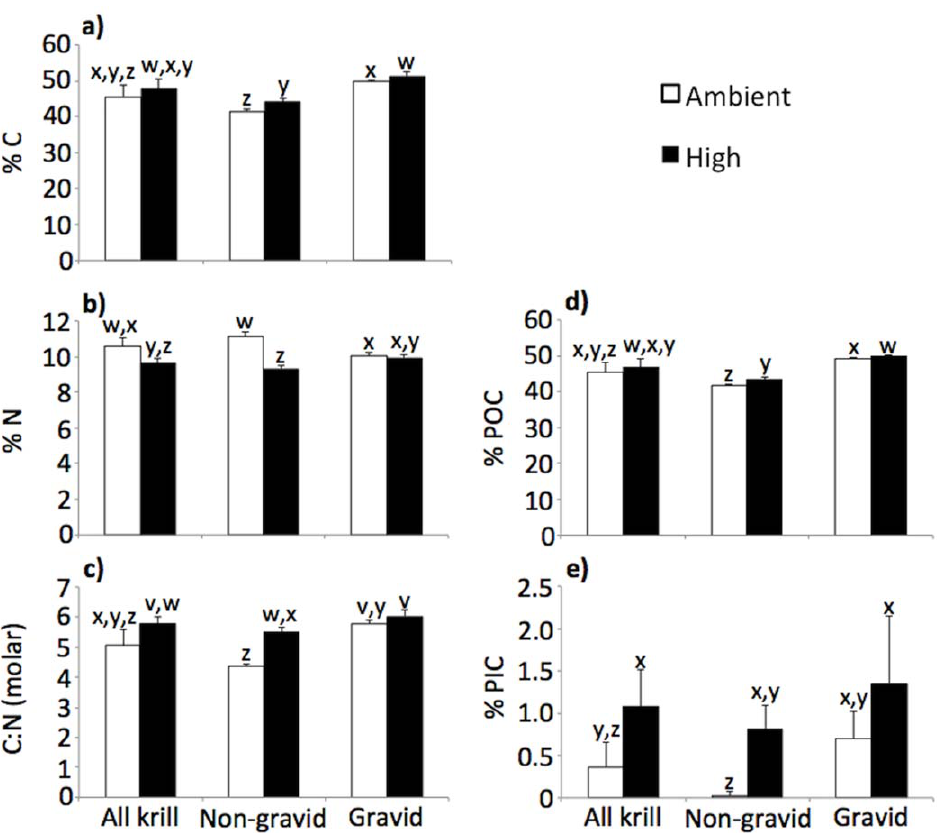
Figure 3. Euphausiasuperba chemical composition. Chemical composition (a: % carbon, %C; b: % nitrogen, %N; c: C:N molar ratio; d: % particulate organic carbon, % POC; and e: % particulate inorganic carbon, % PIC) of krill exposed to ambient and high ( (cid:2) xx =672 ppm) concentrations of CO 2 . Mean of n=4 for non-gravid and gravid krill and n=8 for all krill; error bars=2 6 standard error. v, w, x, and y denote significant differences between treatments (v . w . x . y, p ,